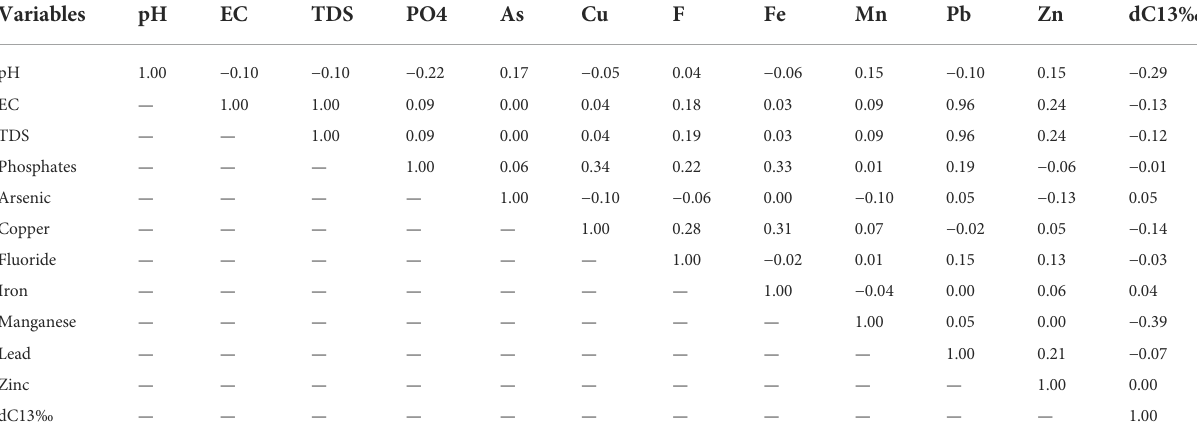
TABLE 5 Correlation coef fi cient between heavy metals and water quality parameters measured in groundwater samples of the “ twin cities. ” Variables